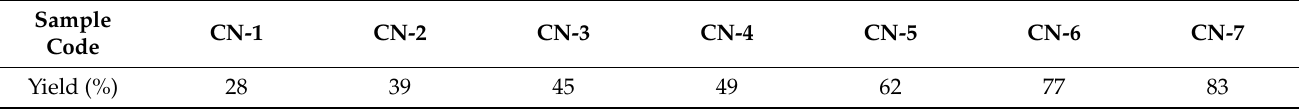
Table 2. Yield data for the obtained